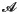
The truncated HOSVD of a 3-mode tensor.Part a shows the original tensor A, and Part b displays the concept of a truncated HOSVD of A.